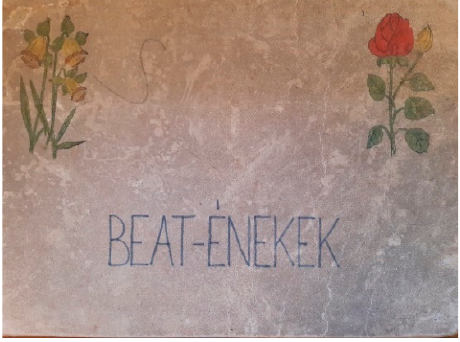
Figure 3. The cover of a home-made song book. (Source: the author’s personal collection).